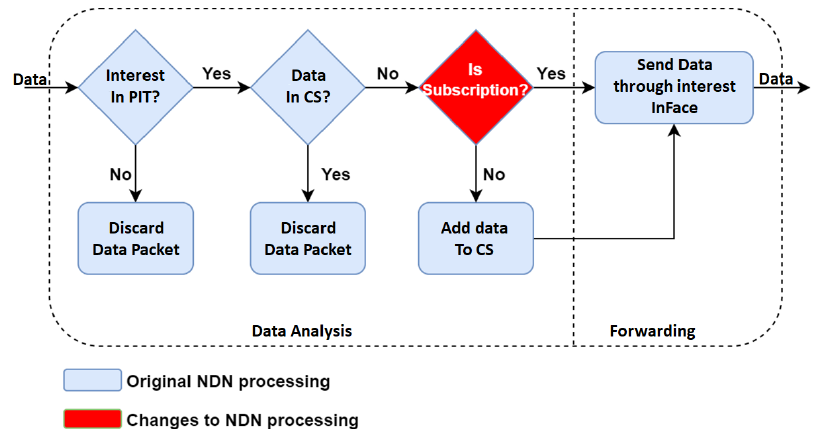
Figure 7. ndnIoT-FC pub-sub Content delivery